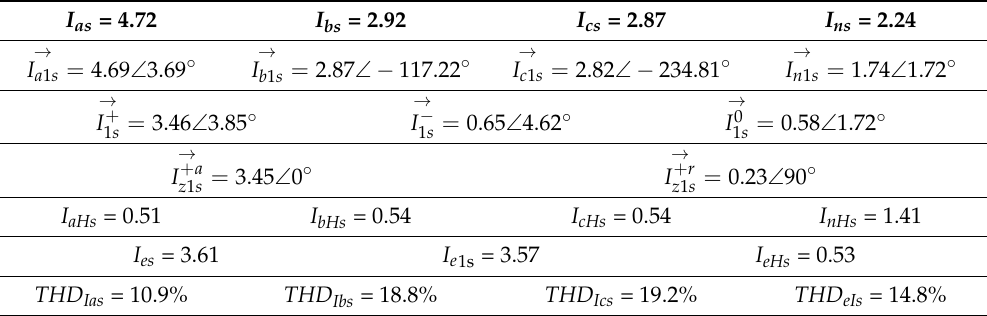
Table 7. Power network current magnitudes when CS4 is applied (in amps).